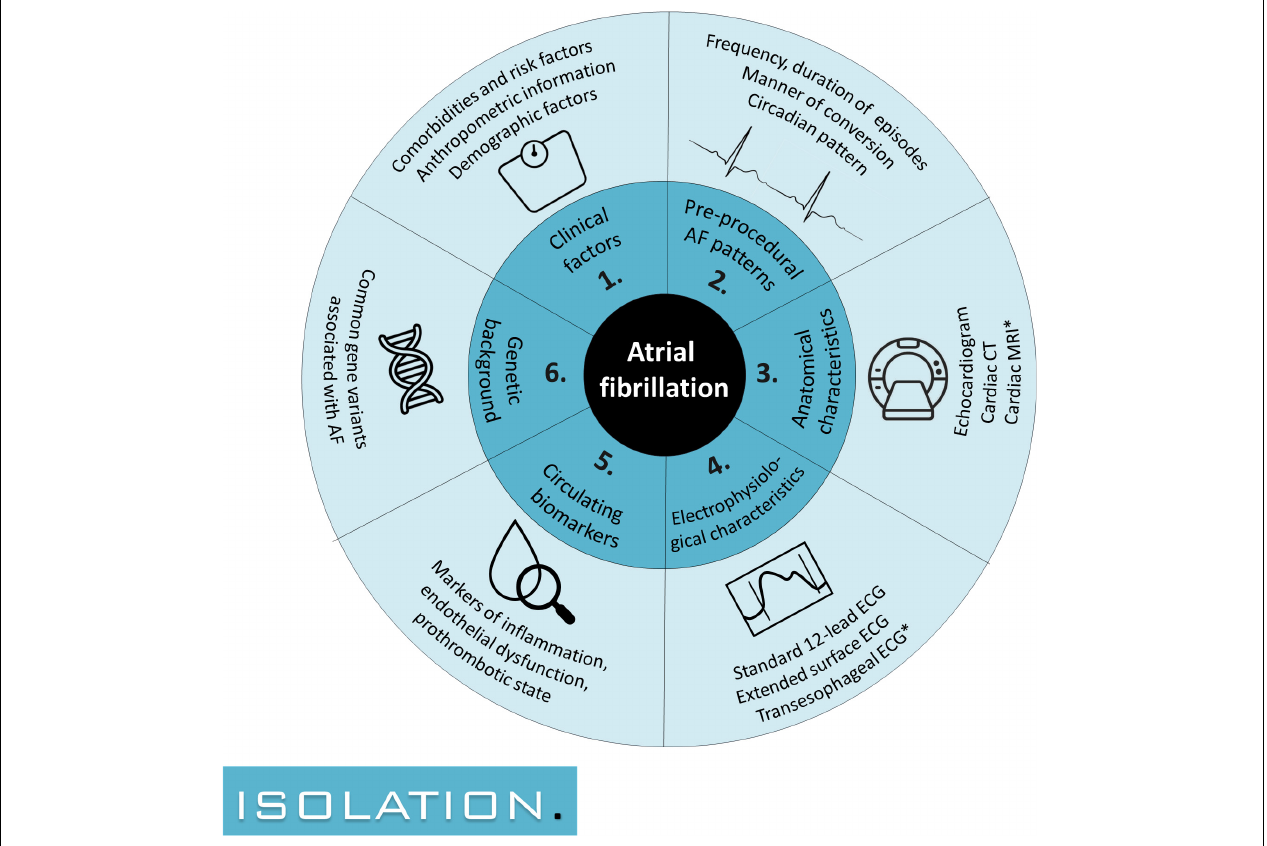
FIGURE 1 | The 6 domains of interest in which predictors for successful atrial fibrillation ablation are sought: (1) clinical risk factors, (2) pre-procedural AF patterns, (3) anatomical characteristics, (4) electrophysiological characteristics, (5) circulating biomarkers, and (6) genetic background. AF, atrial fibrillation; CT, computed tomography; ECG, electrocardiogram; MRI, magnetic resonance imaging. Study procedures with an asterisk are conducted for a subset of patients.